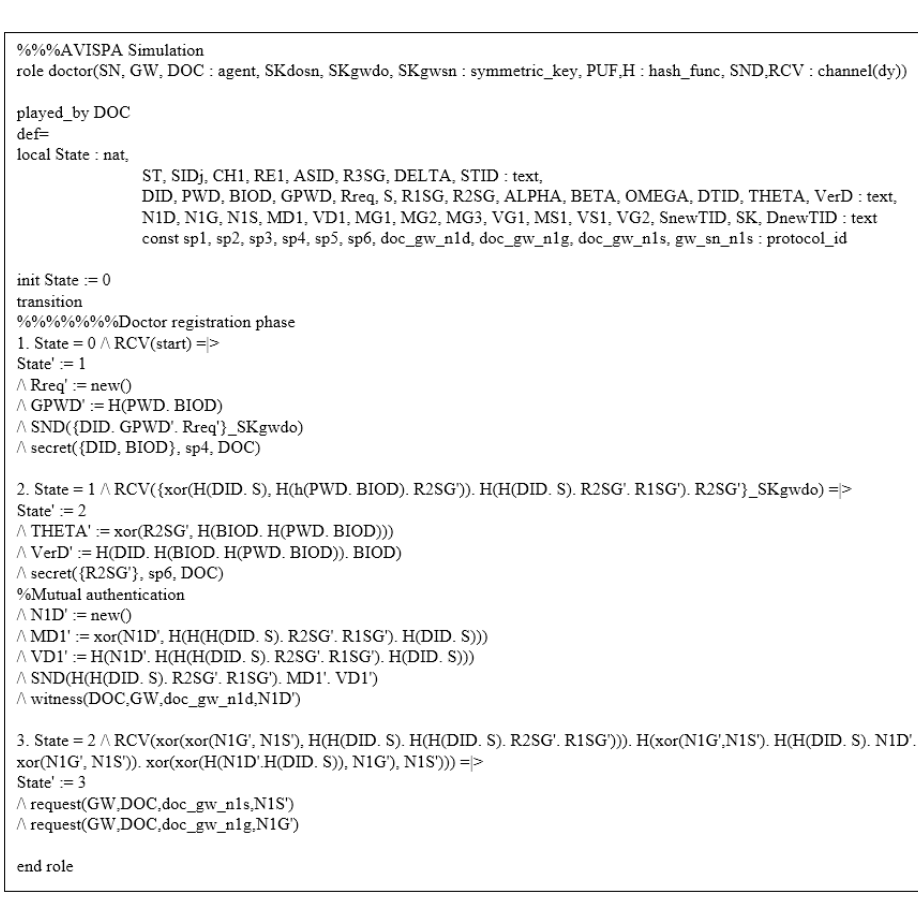
Figure 8. Role specification for the doctor.